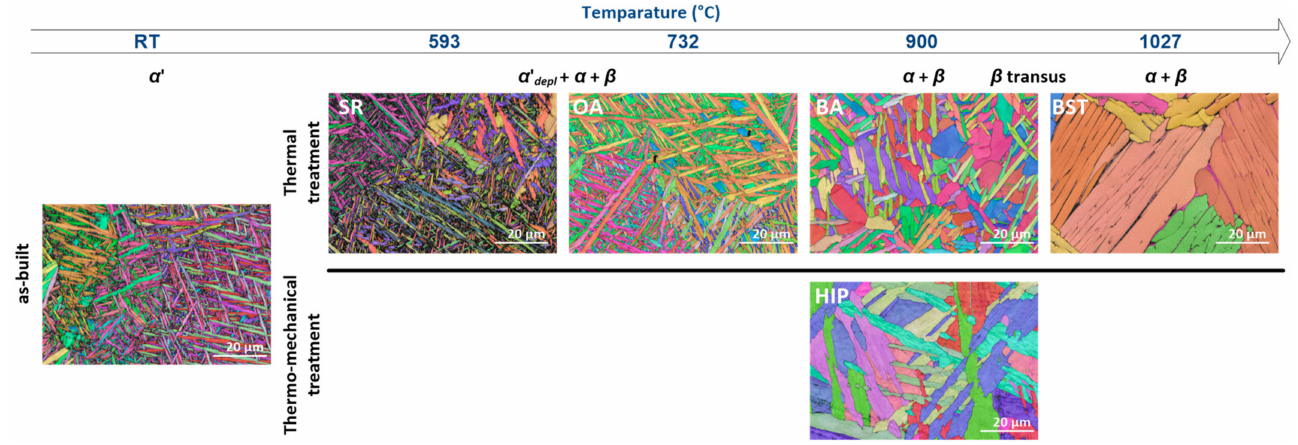
Figure 13. Microstructure after each PT state. The arrow on top shows the temperature of the corresponding stage and the phase